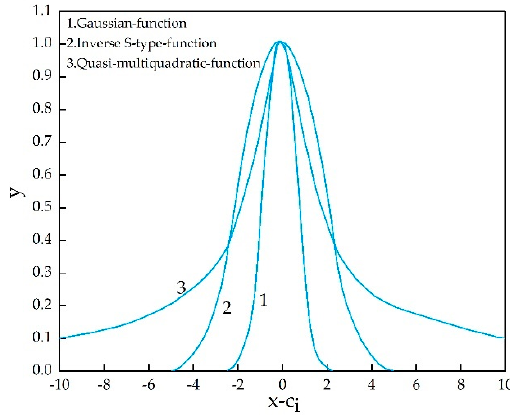
Figure 9. Curves of three typical radial basis functions.